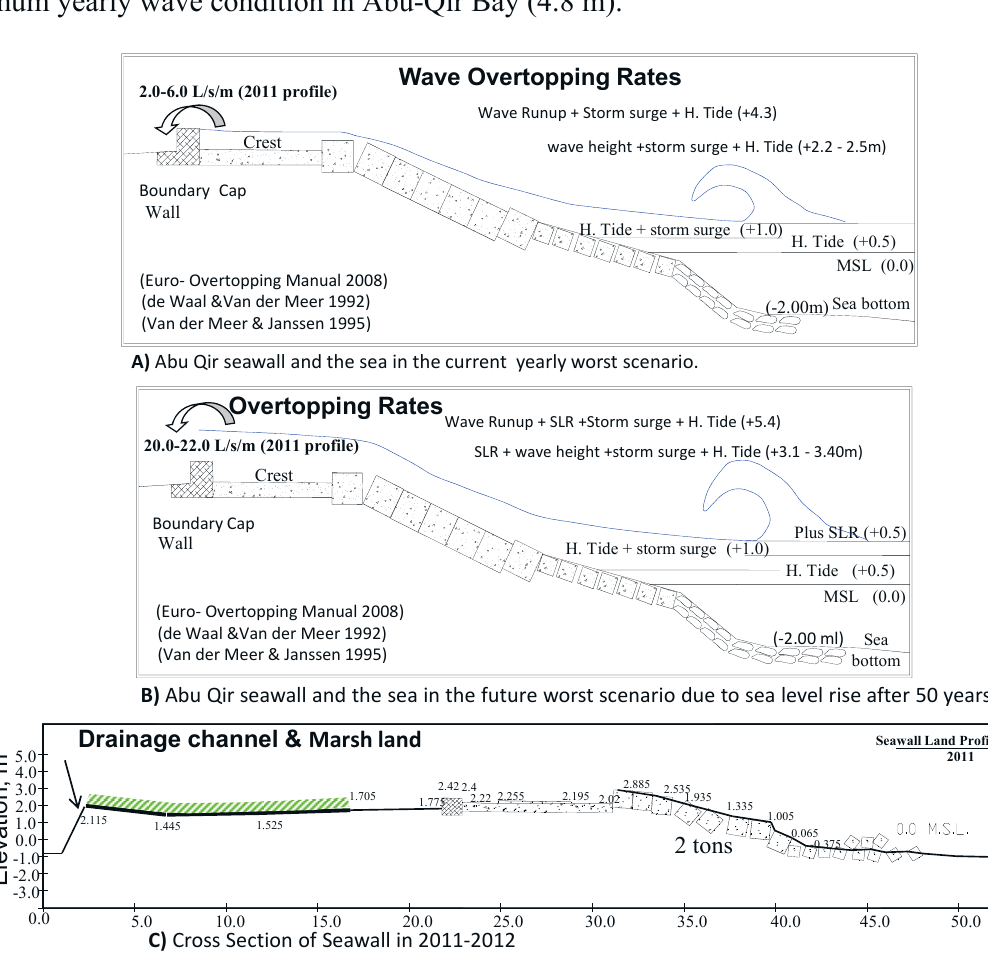
Figure 6. Impact of climate change on the the M.A. design and recommended drainage channel and creation of wetlands. The value of 0.5 m includes projected global sea-level rise and local subsidence